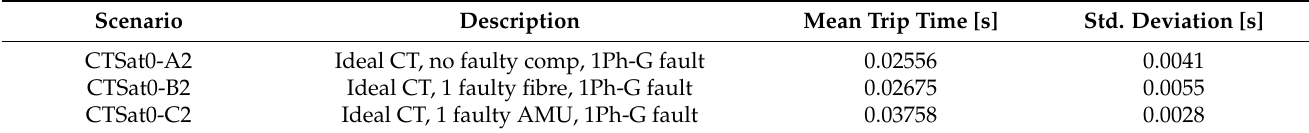
Table 5. Trip times for single-phase-to-ground fault.